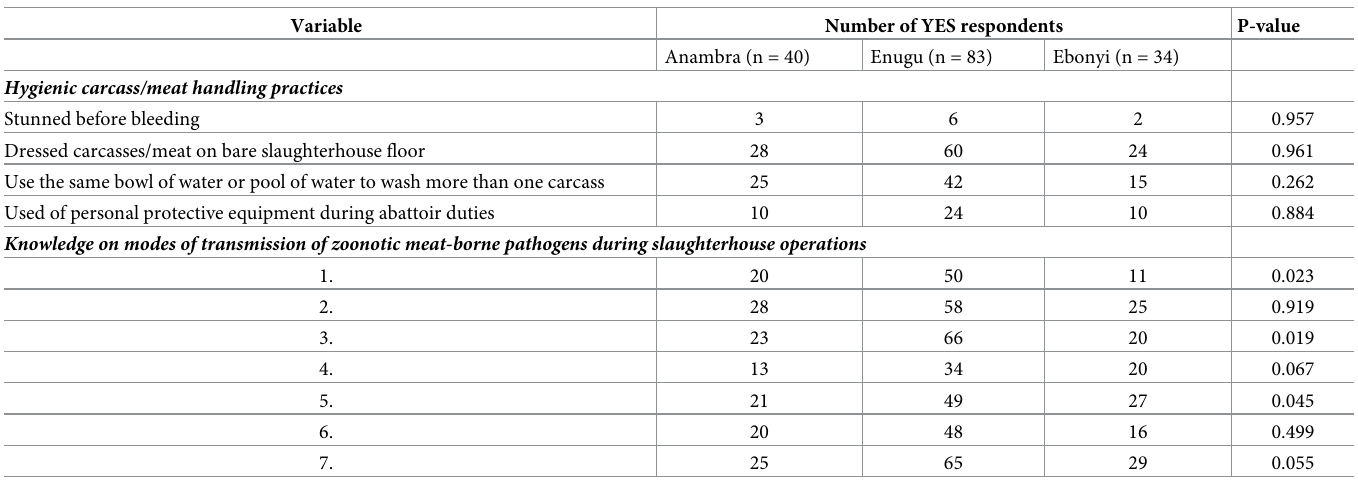
Table 5. Association between geographical location of slaughterhouse workers (n = 157) and their hygienic meat processing practices and knowledge on modes of transmission of meat-borne zoonotic pathogen during routine slaughterhouse operations in Southeast, Nigeria.